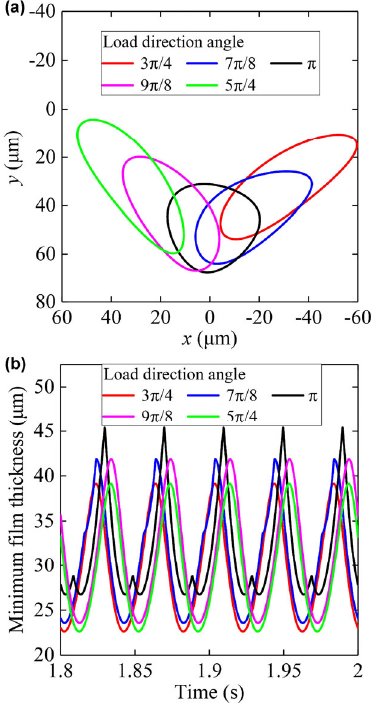
Fig. 20 (a) Journal center orbits and (b) dynamic minimum film thicknesses of a TPJB with static loads for different load